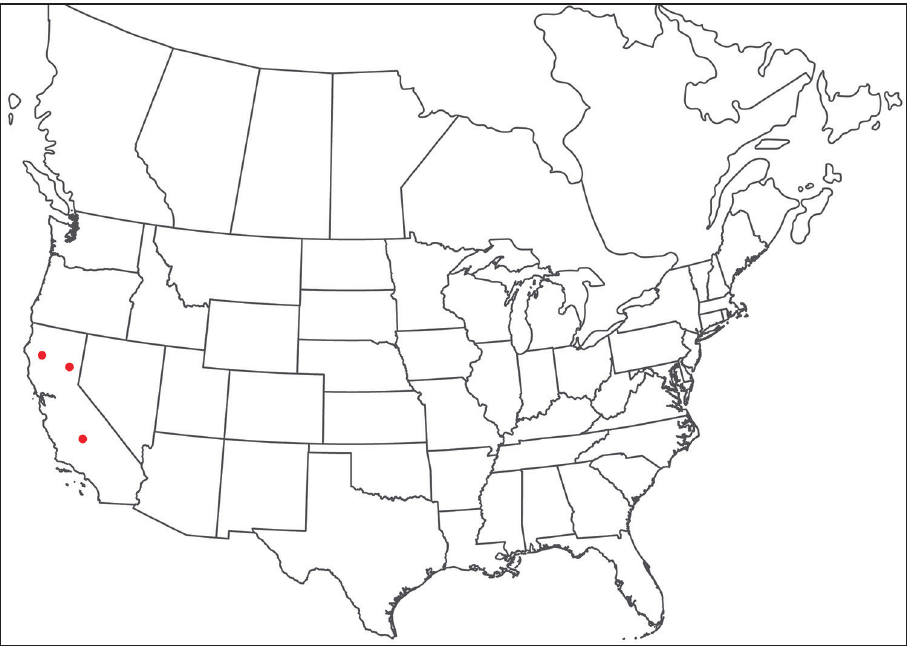
Figure 167. Torrenticola nortoni sp. n.